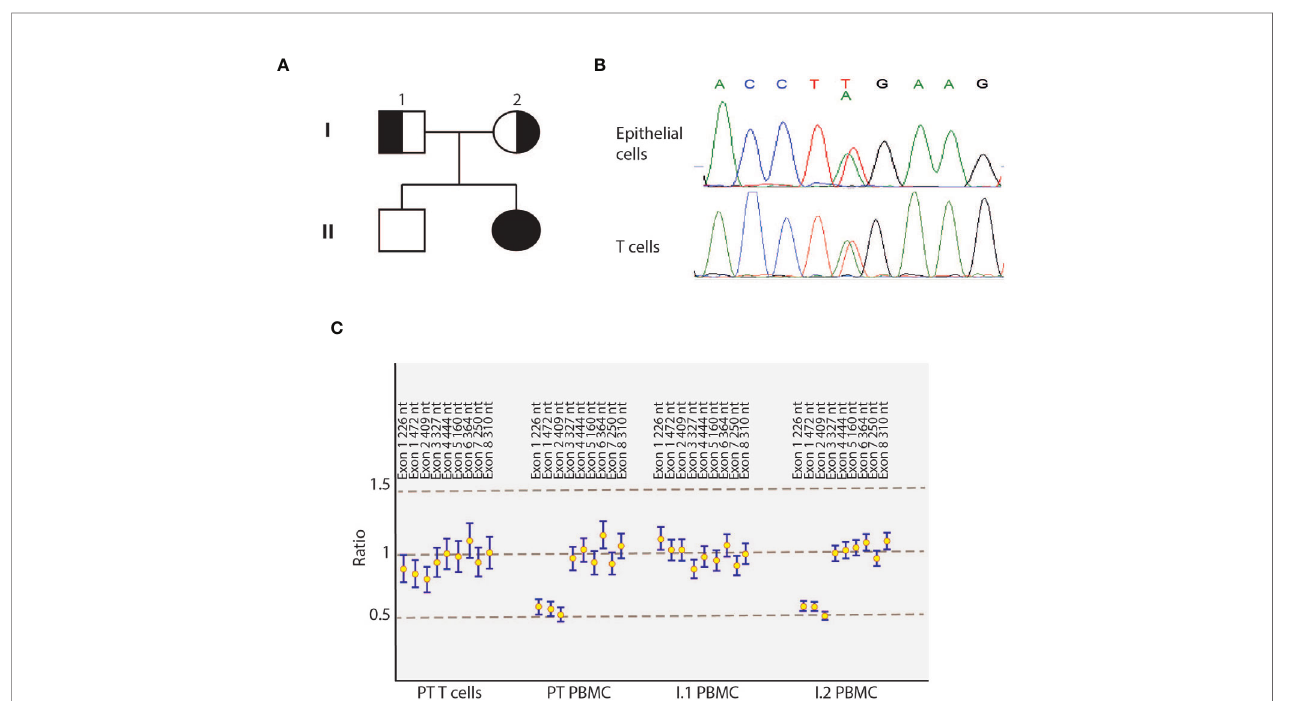
FIGURE 1 | Identi fi cation of compound heterozygous DOCK8 variants in the index patient. (A) Pedigree of the family. Solid symbols indicate affected patient; half solid symbols, heterozygous persons; circles, female family members; square, male family members. (B) Electropherograms showing the novel c.T824A mutation in DOCK8 patient ’ s epithelial cells and T-cell blasts. (C) Reversion of the deletion in patient ’ s T cells blasts detected by multiplex ligation-dependent probe ampli fi cation. PBMC, peripheral blood mononuclear cells; PT,